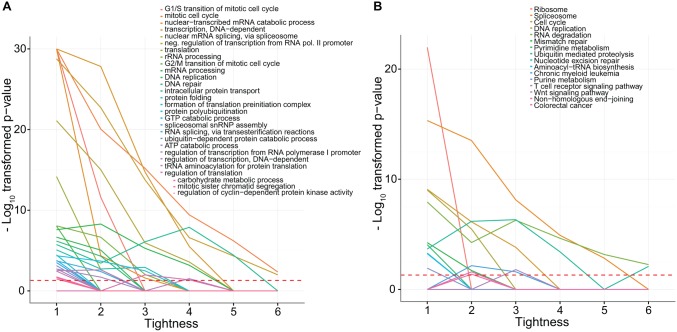
Variation in functional annotation enrichment with increasing tightness between the predicted targets and the ECCN.The significance of 28 enriched GO terms (A) and 16 KEGG terms (B) for genes connected to the CCN steadily decreases for most terms as the minimum number connections is increased (this number of connections between a gene and a gene set is here defined as "tightness"). As the minimum tightness between the predicted targets and the ECCN increases, the enrichment and rank of functional annotation changes. We observe an overall decrease in enrichment but little in rank. The greatest changes in rank occur between a tightness of 2 and 3. At a tightness of two and above, the rank of the majority of significant GO terms such as "mitotic cell cycle" and "nuclear mRNA splicing, via spliceosome", and KEGG terms such as "Spliceosome", "Ubiquitin mediated proteolysis" and "RNA degradation" remain largely stable suggesting a natural threshold on tightness at this point.